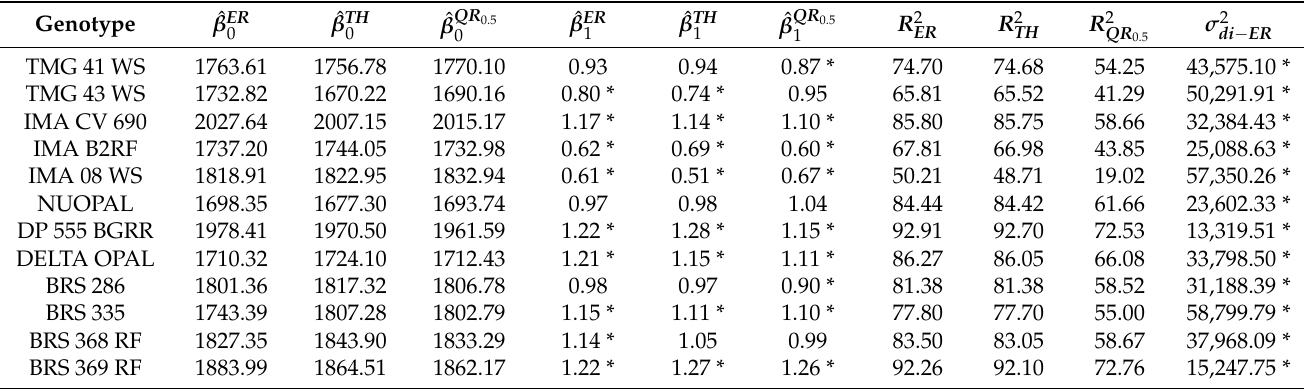
12 (BRS 369 RF) was characterized as having wide adaptability using this method and was recommended for favorable environments by non-parametric and quantile regression methodologies (Table 4 and Figure S6). The recommendation of the other genotypes can consider the Eberhart and Russell results. Genotype six (NUOPAL) was not affected by the “influential point” (Table 4 and Figure S7). Table 3. Estimate of adaptability and stability parameters by the Eberhart and Russell (1966), non-parametric and quantile regression methodologies of yield of 12 early cotton genotypes (experimental data). Genotype